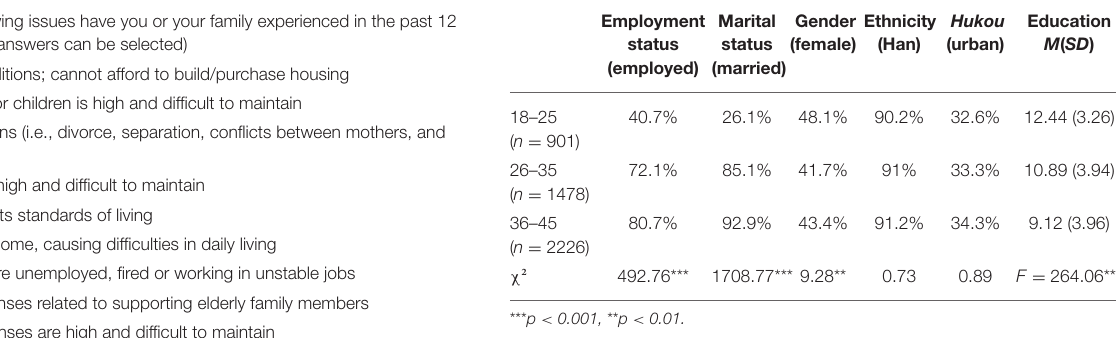
TABLE 1 | Objective uncertainty measure.